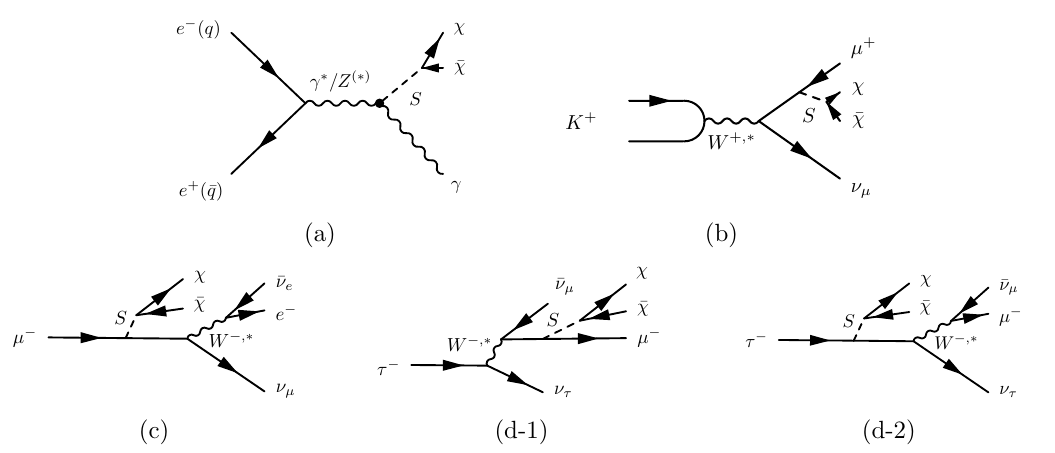
Figure 8. Diagrams sensitive to g (cid:22) or the g (cid:22) -induced g (cid:13)(cid:13) coupling in the muon-speci(cid:12)c model and contributing to (a) e + e (cid:0) ( q (cid:22) q ) ! (cid:13)S , (b) K + ! (cid:22) + (cid:23) (cid:22) S , (c) (cid:22) (cid:0) ! e (cid:0) (cid:23) (cid:22) (cid:22) (cid:23) e S , and